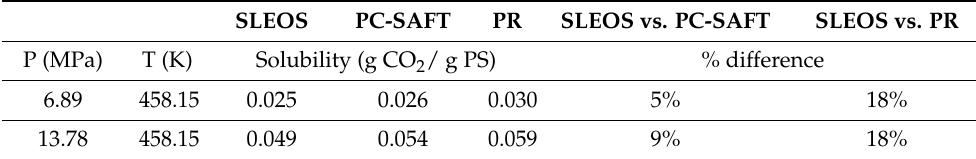
Table 13. Comparison of solubility using different EOS: SLEOS, PC-SAFT and PR. SLEOS PC-SAFT PR SLEOS vs. PC-SAFT SLEOS vs. PR P (MPa) T (K) Solubility (g CO 2 / g PS) % difference 6.89 458.15 0.025 0.026 0.030 5% 18% 13.78 458.15 0.049 0.054 0.059 9%